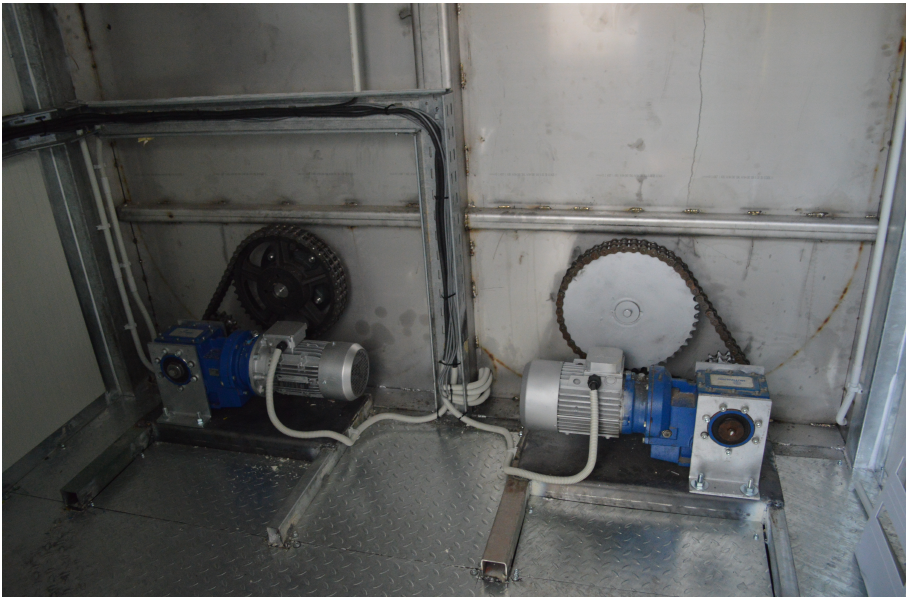
Figure 6. Frame motors.